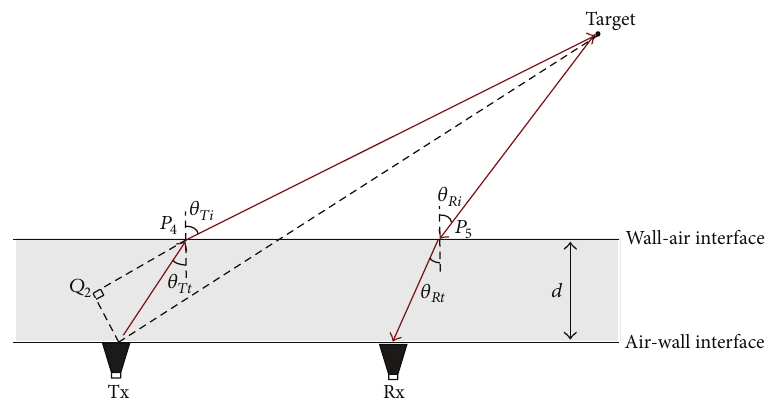
Figure 3: Equivalent two-layer propagation model.